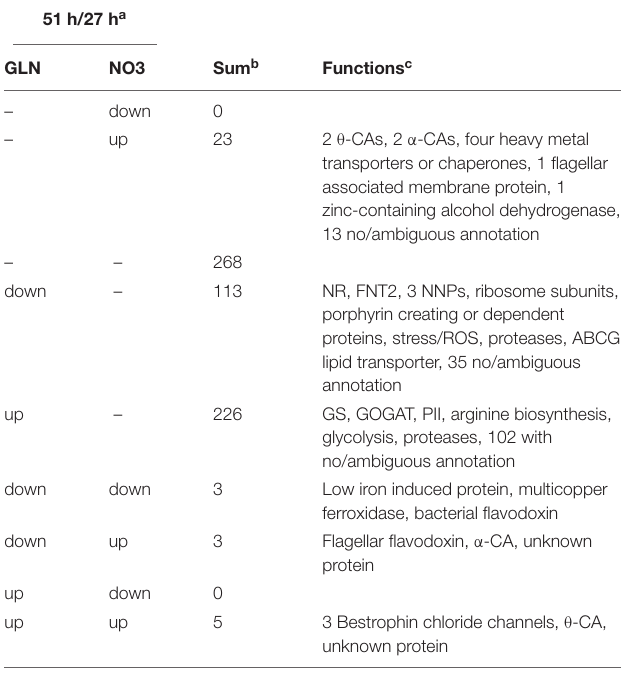
TABLE 1 | Transcription patterns for differentially expressed genes in GLN and